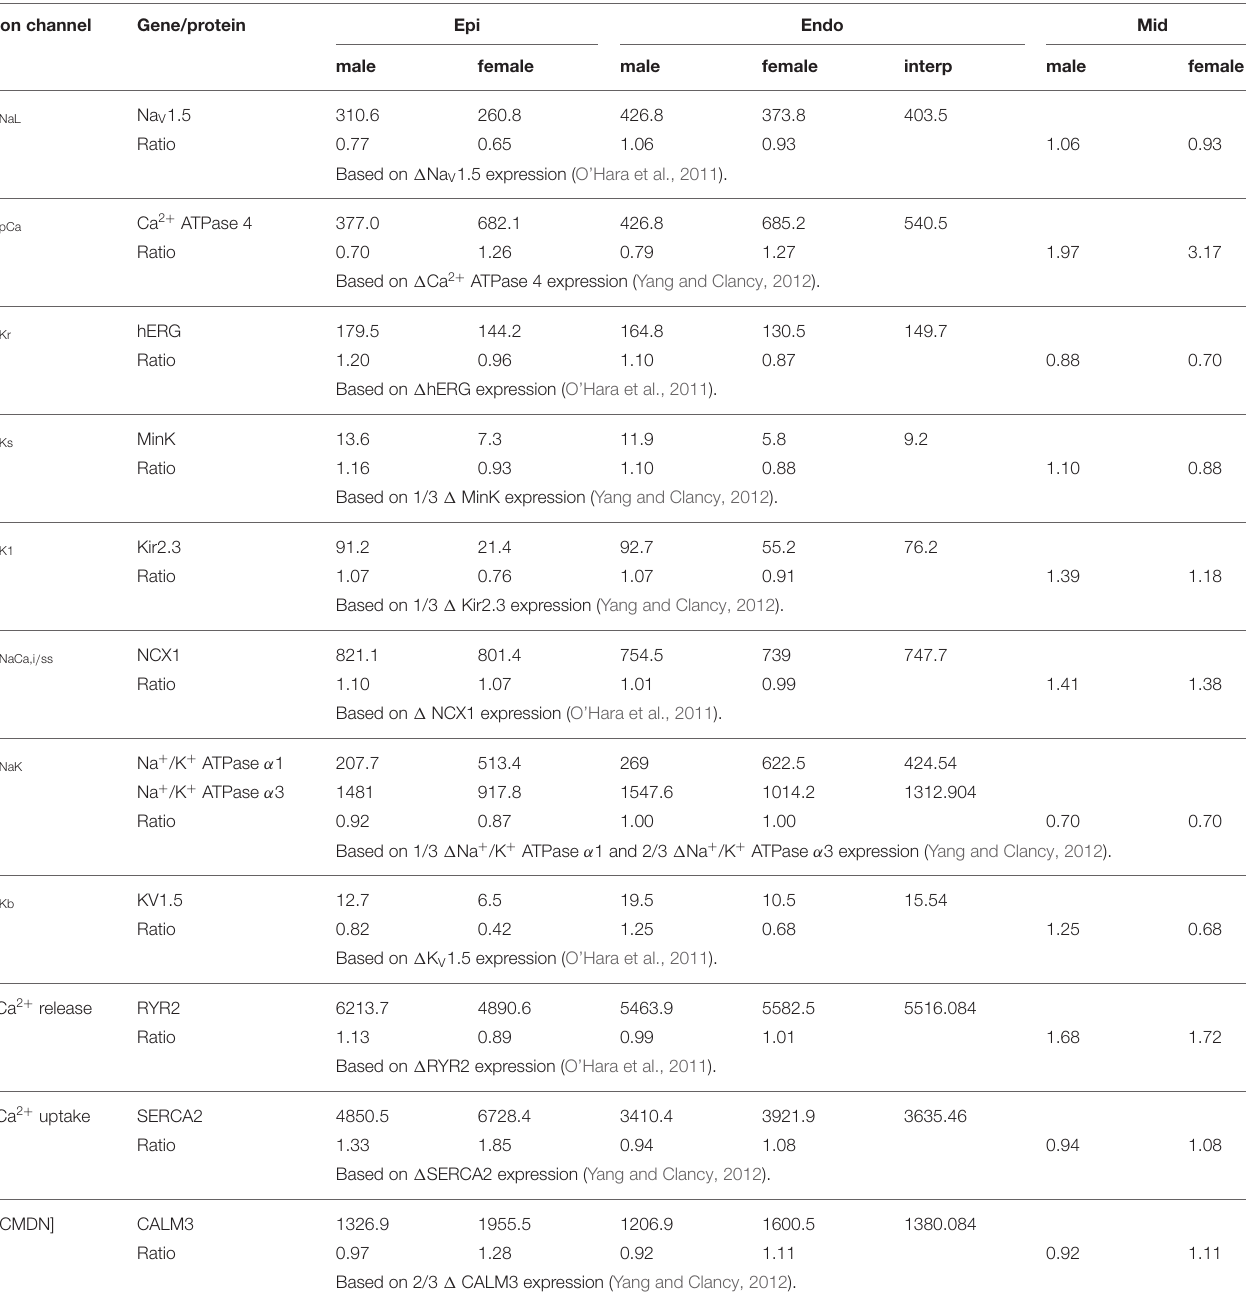
TABLE A1 | Sex-based differences in ion channel subunit expression from non-diseased human ventricles. Ion